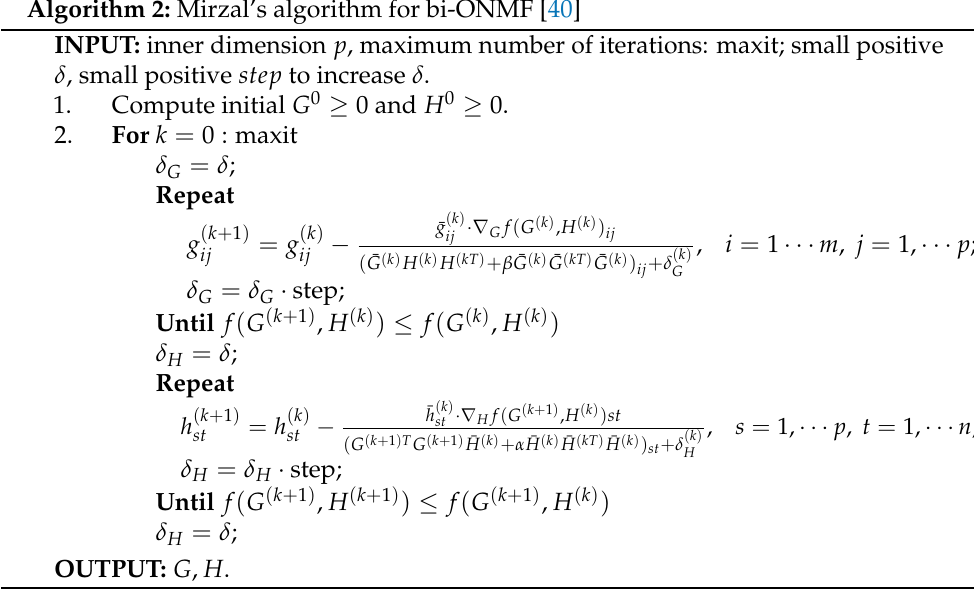
Algorithm 2: Mirzal’s algorithm for bi-ONMF